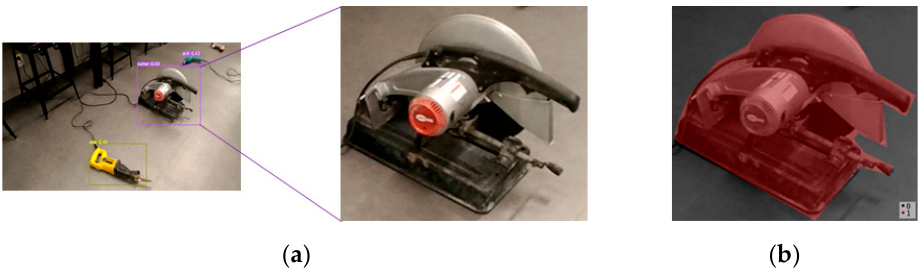
Figure 2. Detection models outcome image and its segmentation. ( a ) Result of YOLOv5 models, ( b ) segmented result image.